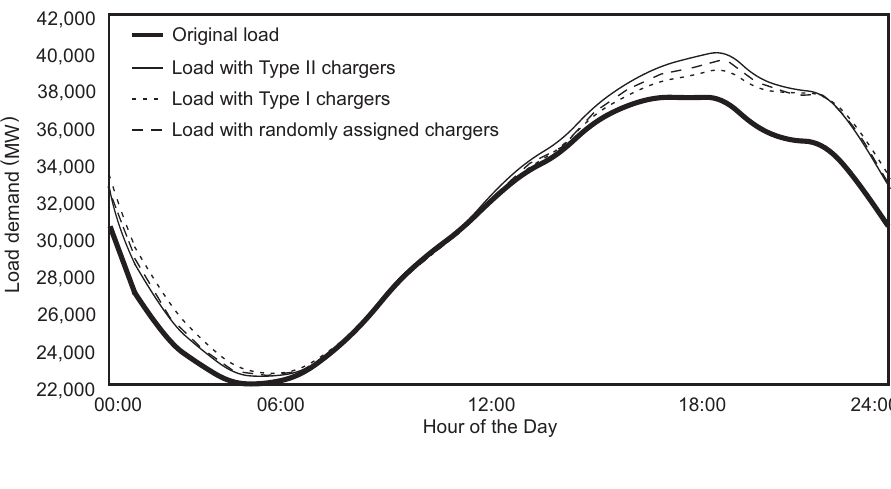
Figure 4. Residential load as a function of charger type.